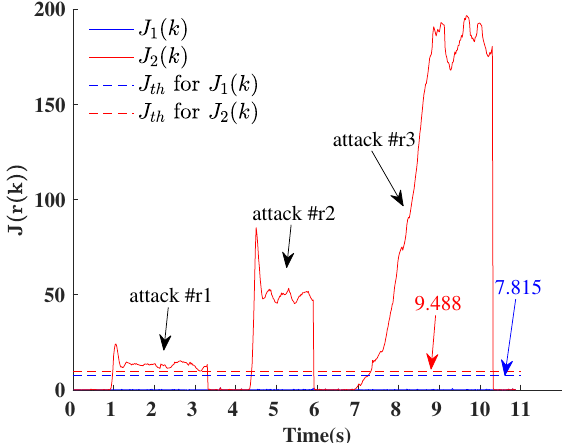
Figure 9. The detection results of replay attacks based on r 0 ( k ) and r β ( k )